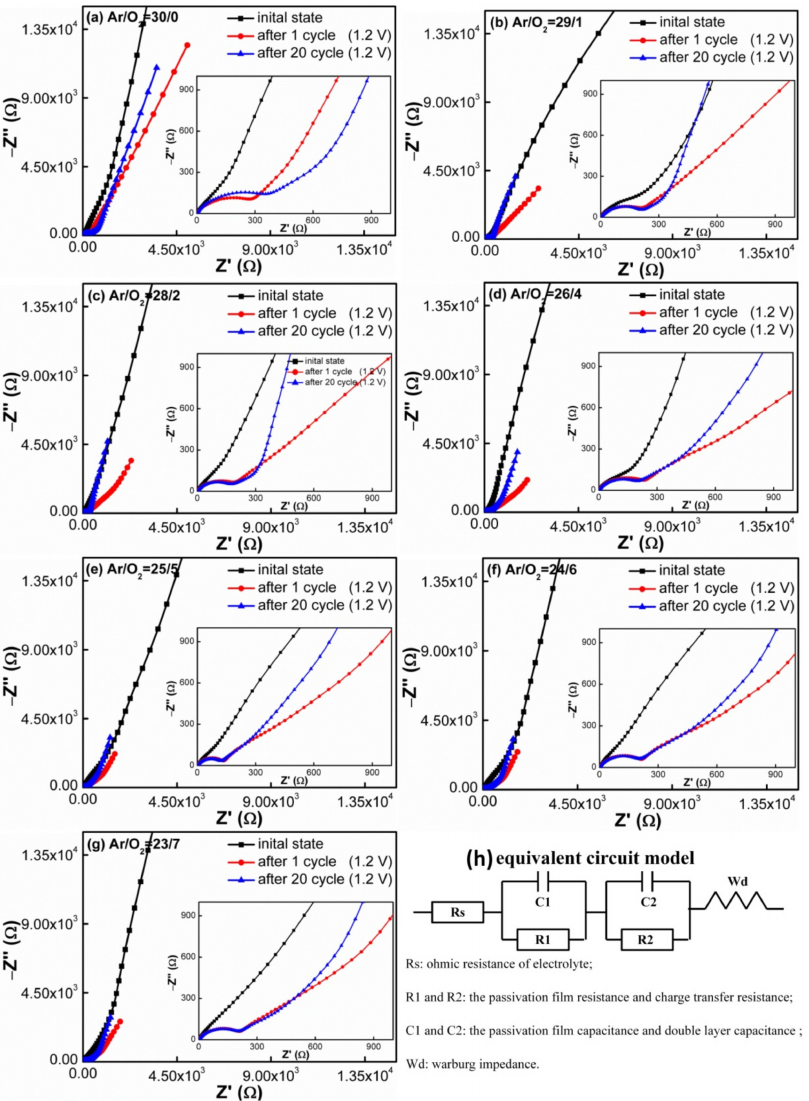
Figure 8. Impedance spectra of the SnO x films deposited at different Ar/O 2 flow ratios: ( a ) 30/0, ( b ) 29/1, ( c ) 28/2, ( d ) 26/4, ( e ) 25/5, ( f ) 24/6 and ( g ) 23/7. The schematic diagram in ( h ) shows the equivalent